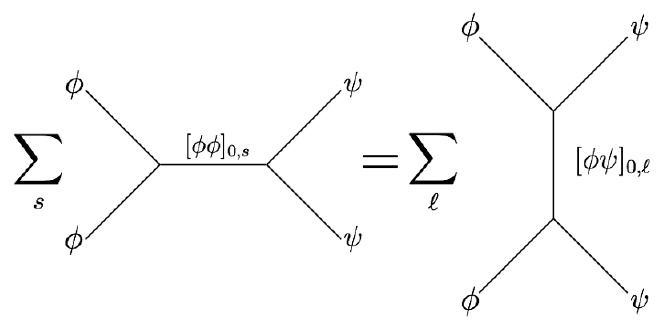
Figure 2 . Crossing equation with double-twist dominance in t